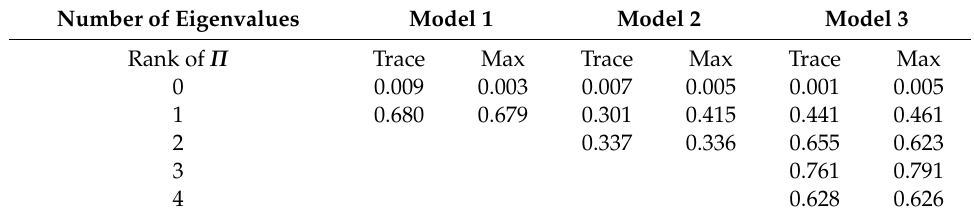
Table 3. p -Values for Johansen’s Rank Tests 1999:1–2018:12.